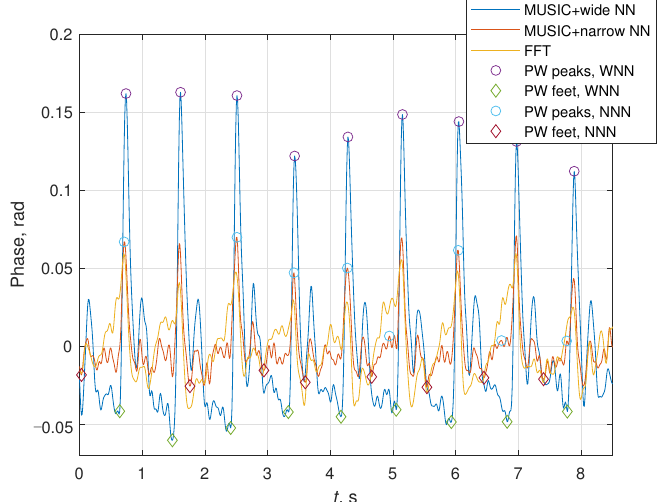
Figure 9. Fragments of PW signals demodulated using conventional FFT-based algorithm and the proposed MUSIC-based algorithm. For the signals demodulated using MUSIC-based algorithm (with wide and narrow NNs used for number of interference components estimation) systolic peaks and wave feet are also